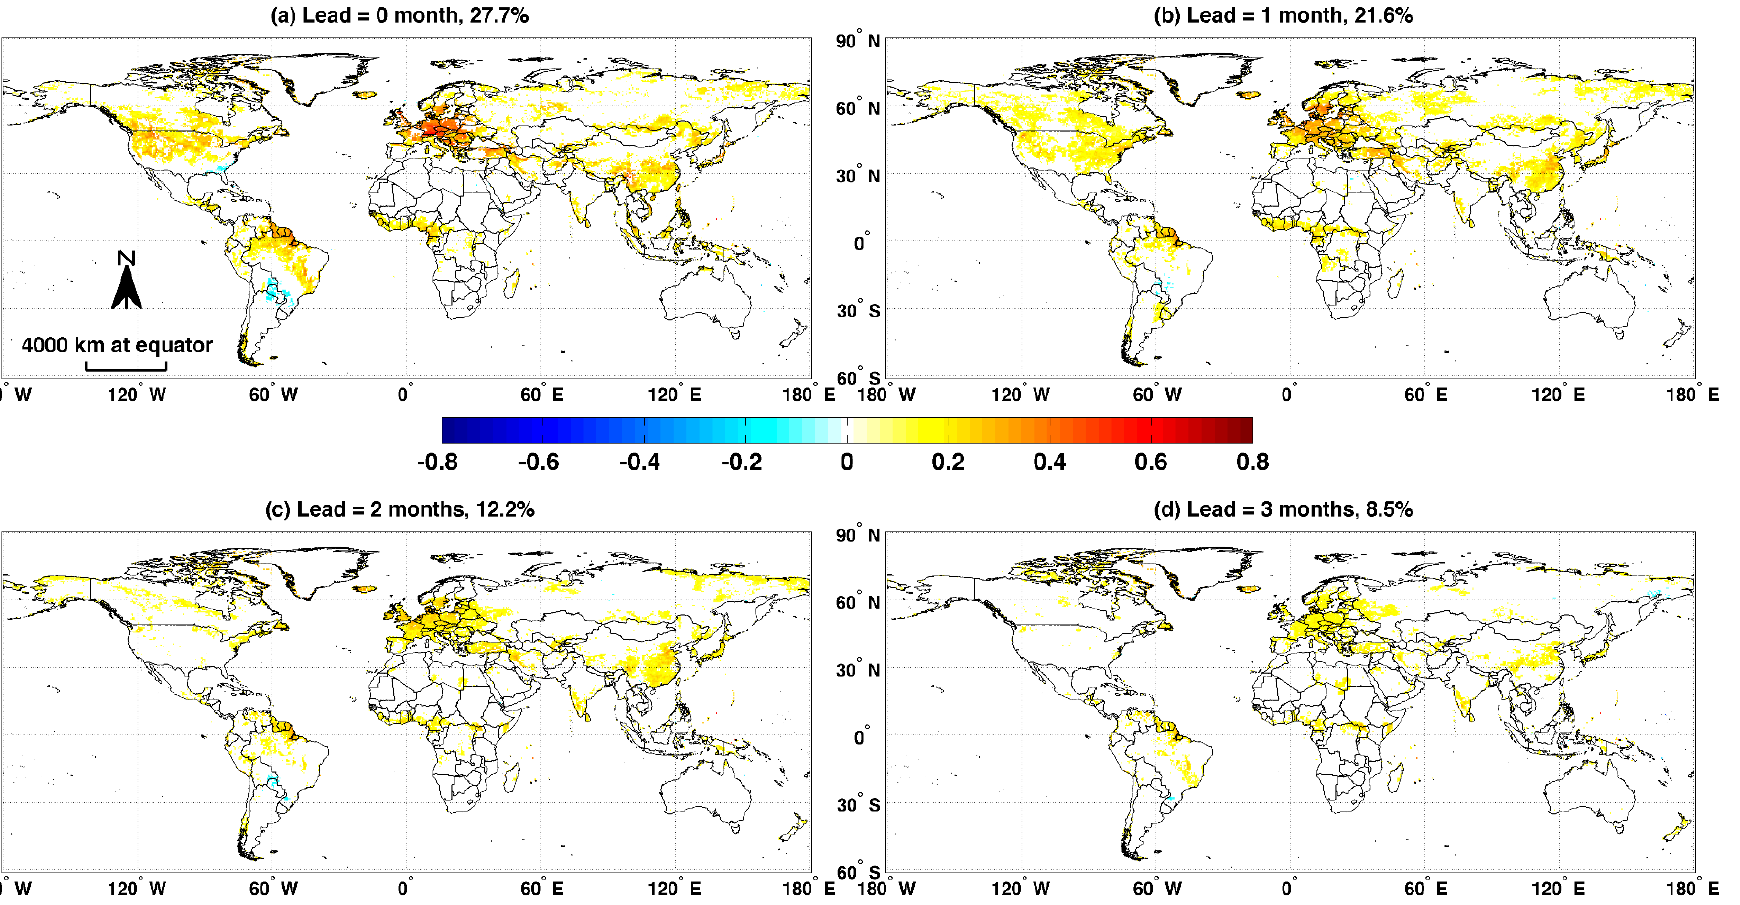
Figure 6. Global maps of correlation coefficients ( p* < 0.05) between all monthly GIMMS NDVI and GISS temperature anomalies with lead times varying from 0 to 3 months for 1982–2010 (( a – d) , N = 348 − lead), after removal of grid cells with significant ( p* < 0.05) negative correlation between GIMMS NDVI and MODIS Terra snow cover (MOD10CM V5). All the correlations have been corrected for temporal autocorrelation. The percentage represents the fraction of land grid cells that have significant ( p* < 0.05) positive correlations (Spatial resolution: